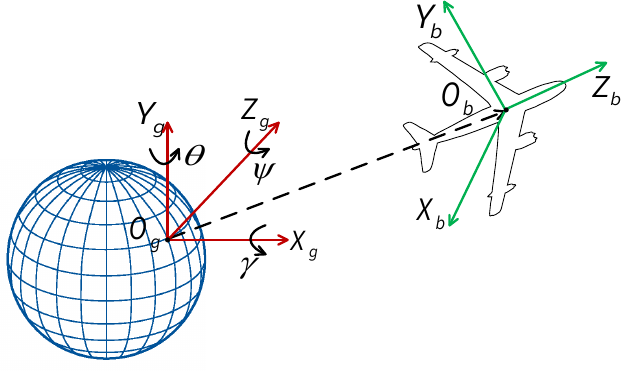
Figure 1. Coordinate system